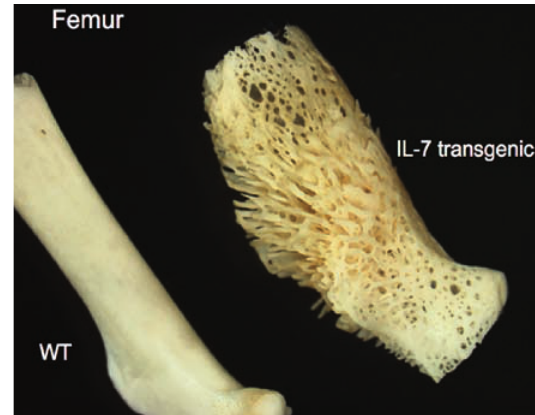
Figure 4 Femur of wild type (left) and IL-7 trans- genic (right) mouse. IL-7 overexpression leads to osteolysis, lacuna formation and contraction in